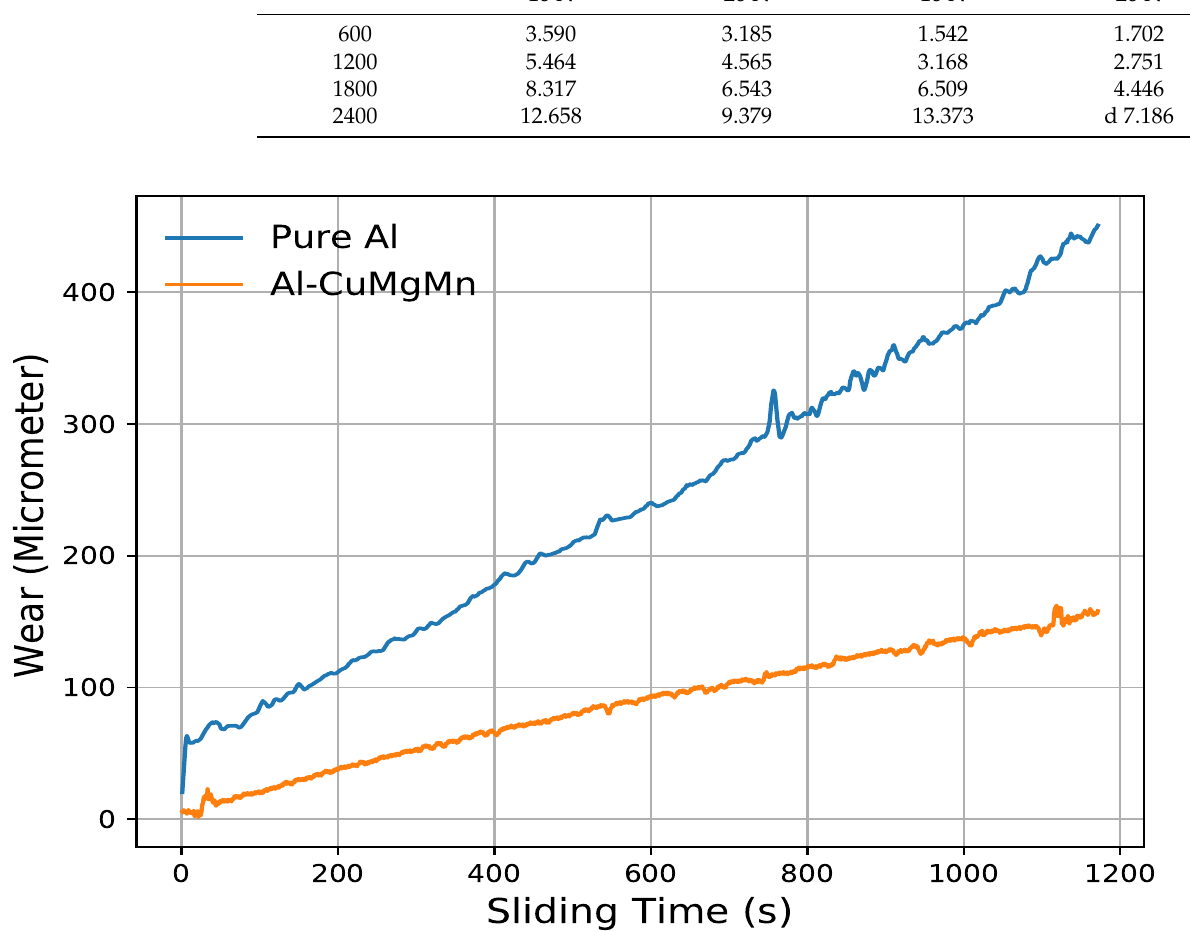
Figure 12. Online wear values of laser-surface-alloyed samples and aluminum for 20 N normal load and 2 m/s sliding speed